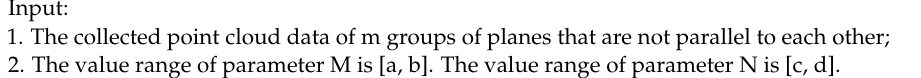
Algorithm 1: Calibration of self-rotating, LSL scanning, 3D reconstruction system based on plane constraints.